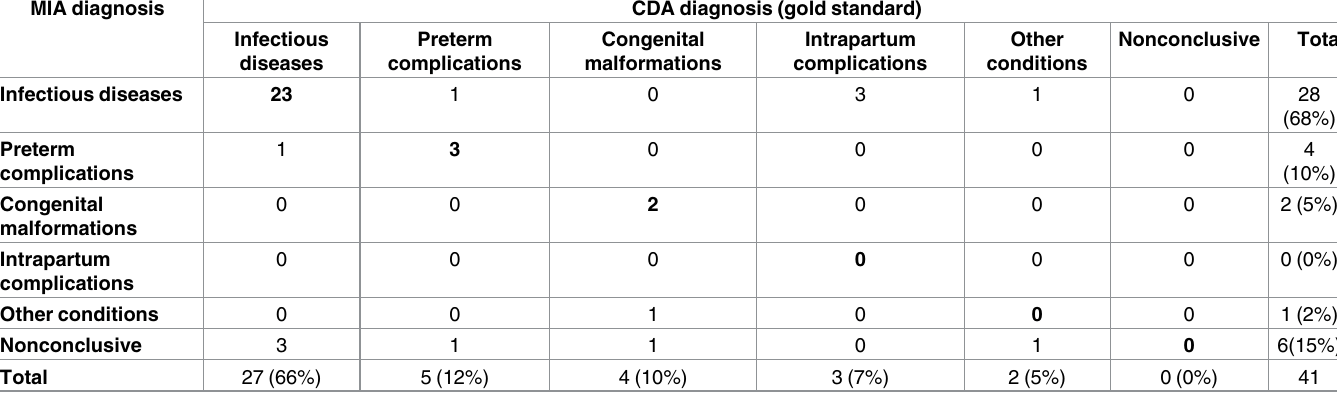
Table 3. Concordance of the categorization of the cause of death established by the complete diagnostic autopsy (CDA, gold standard) and the minimally invasive (MIA) diagnosis in neonates. MIA diagnosis CDA diagnosis (gold